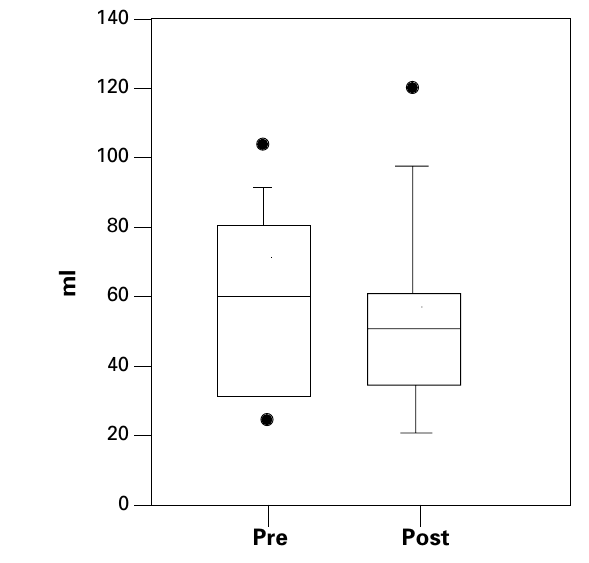
Volume of initial rectal sensation.